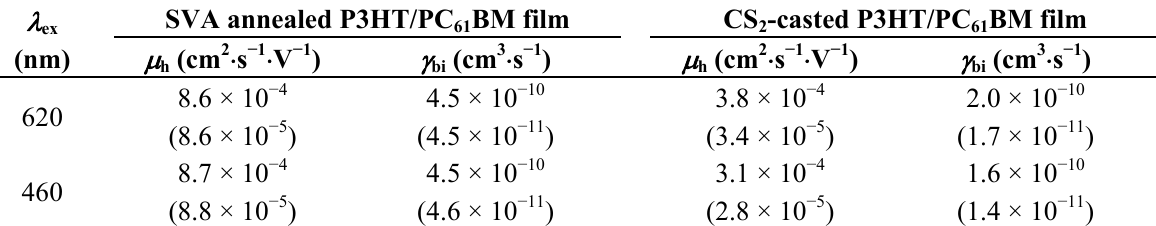
Table 1. Averaged hole mobility (  taken over a number of independent determinations under different hole concentrations ( cf Figure